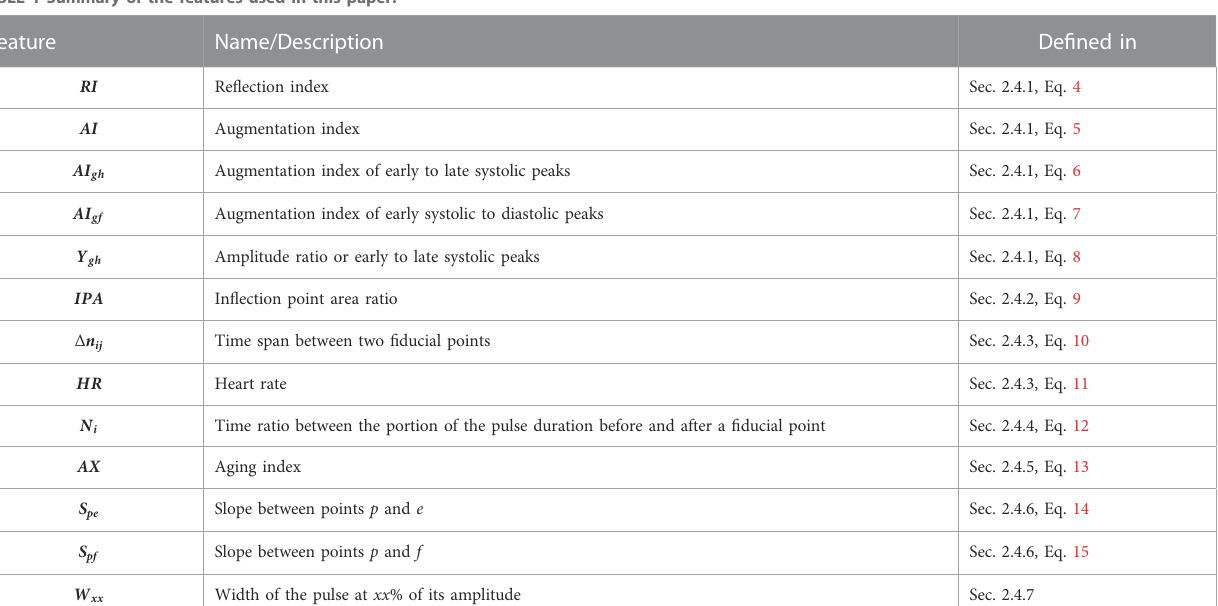
TABLE 1 Summary of the features used in this